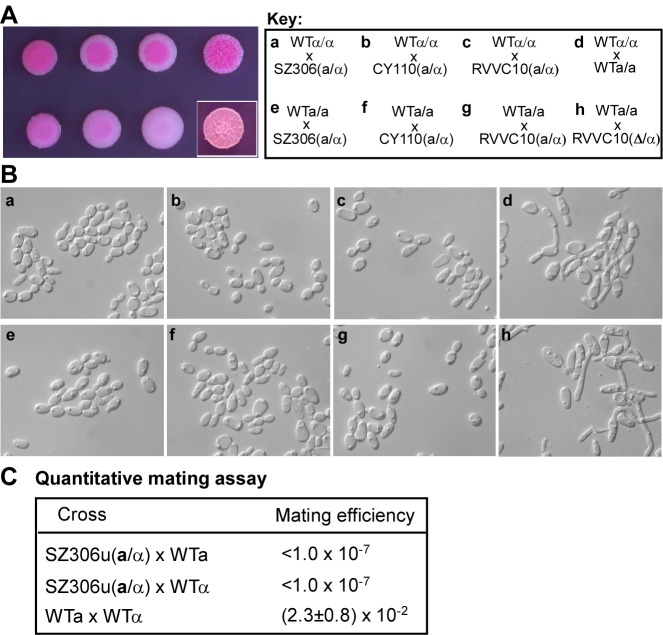
Opaque cells of C. albicans MTLa/α strains cannot mate with a/a or α/α opaque cells.106 opaque cells of each mating partner were mixed and spotted onto Lee's GlcNAc agar and incubated at 25°C for 4 days. (A) Patches of a/α cells and a/a or α/α mixture on Lee's GlcNAc medium at 25°C. Three natural a/α isolates were tested. WTa/a (GH1012) and α/α (WO-1) mixture served as a positive control of mating assay. Wrinkle surface indicated the formation of long mating conjugation tubes. (B) Mating response of corresponding patches in panel A. Cell fusion and mating conjugation tubes were only observed in the crosses of (d) and (h). (C) Quantitative mating assay. SZ306u (MTL
a/α, ura3-), WTa (SN152a, MTL
a/Δ, arg4-his1-leu2-), WTα (GH1349, a derivative of WUM5A, MTLα/α, agr4-, used for the SZ306u × WTα cross), and WTα (WUM5A, MTLα/α, ura3-, used for the control WTα × WTa cross). Mating efficiency = average ± SD. “<” indicated no prototropic colonies were observed. Opaque cells were used for all the mating crosses.